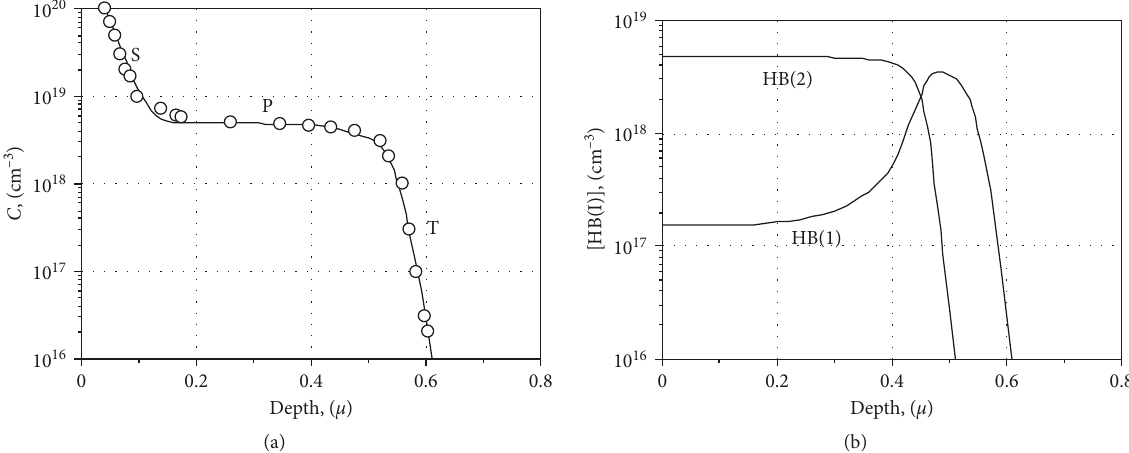
Figure 1: Hole depth profile in a sample of N Curve 1: with D + K with the parameters specified in the text.